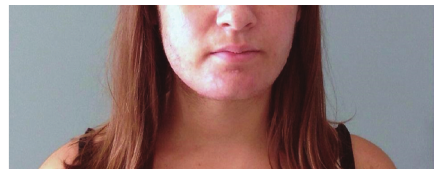
Figure 5: Six months after